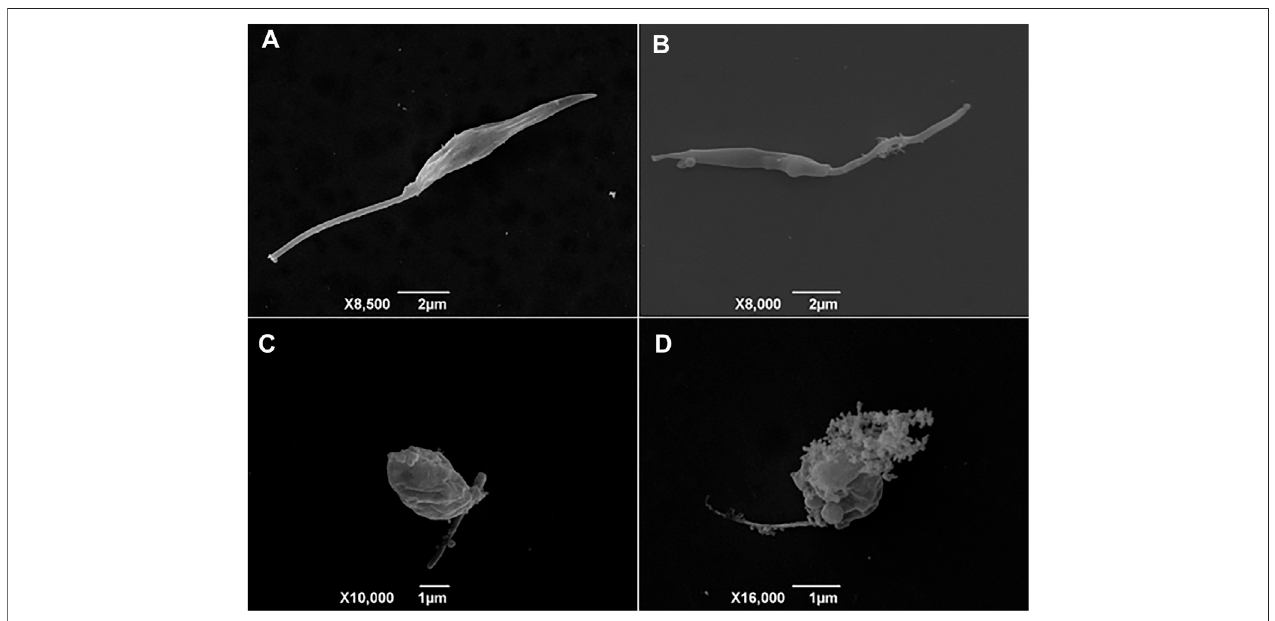
FIGURE 3 | Scanning electron microscopy (SEM) analysis of promastigotes of L. amazonensis incubated with BA5. (A) Untreated control cells with normal morphology, (B) parasites treated with IC 50 /2 value of BA5, (C) parasites treated with IC 50 value of BA5, (D) parasites treated with twice the IC 50